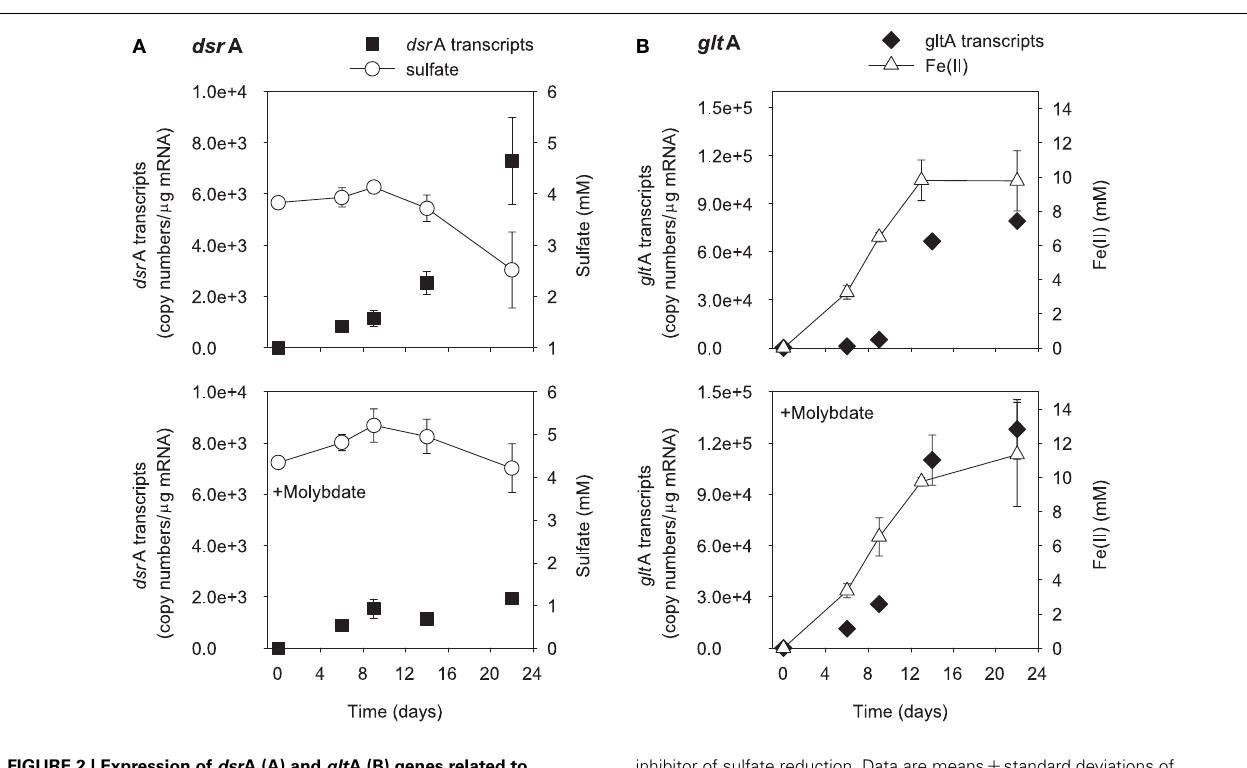
FIGURE 2 | Expression of dsr A (A) and glt A (B) genes related to electron acceptor reduction in acetate-biostimulated microcosms. The lower panels show treatments amended with molybdate as an